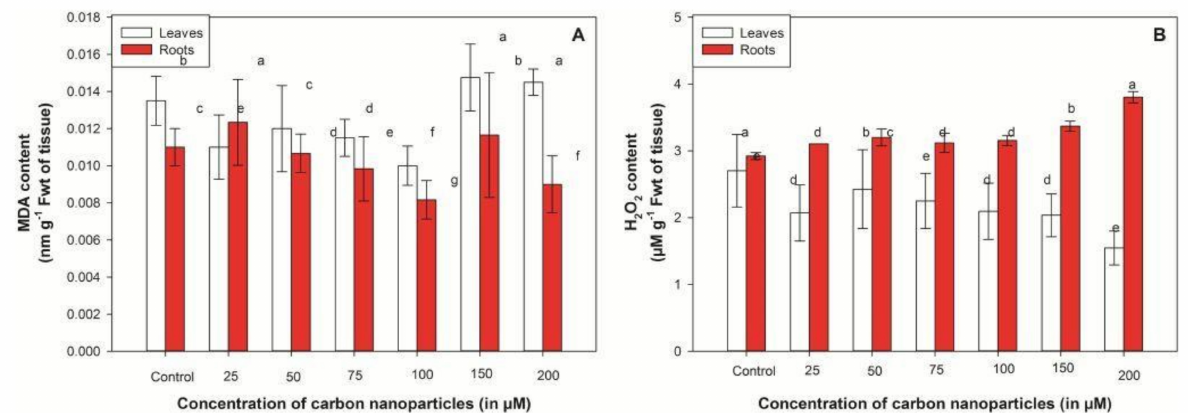
Figure 3. Effect of CNPs on MDA ( A ) and ROS formation (H 2 O 2 production) ( B ) in Vigna radiata seedlings. Seedlings were treated with 25, 50, 75, 100, 125, 150 and 200 µ M CNPs for a period of 96 h. Values are mean ± standard deviation ( n = 3) and are statistically significant according to the DMRT test ( p < 0.05). Data points marked with different letters show significant differences ( p < 0.05) within